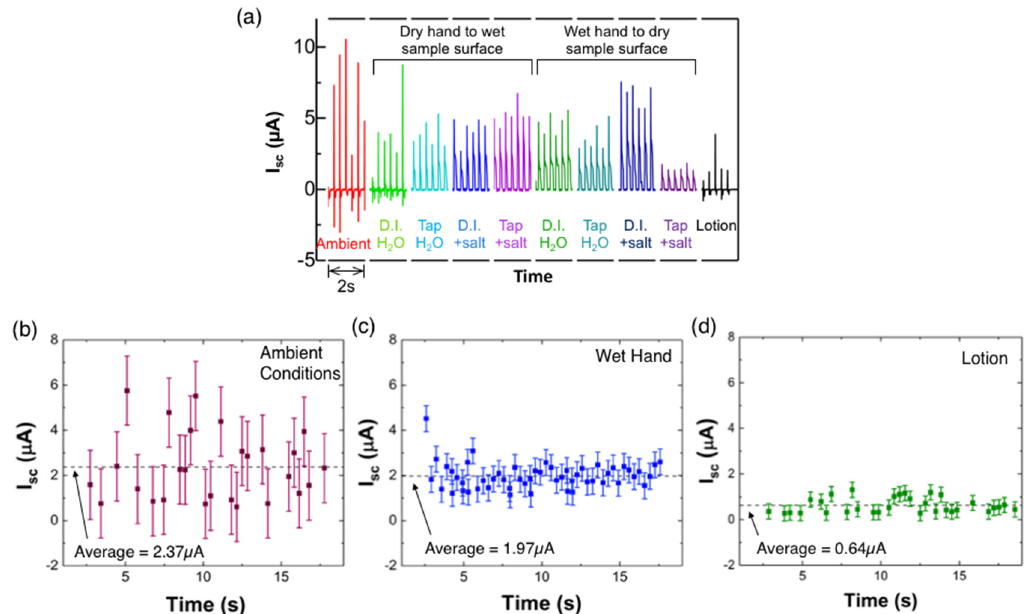
Figure 4. ( a ) Current output generated upon repeated skin contact and separation under different testing conditions. Peak values of current output with standard deviations for ( b ) Normal (dry sample, dry hands), ( c ) Wet hand touch actions, and ( d ) Touches with a small amount of lotion on skin. The dashed lines indicate the average peak value for each case.